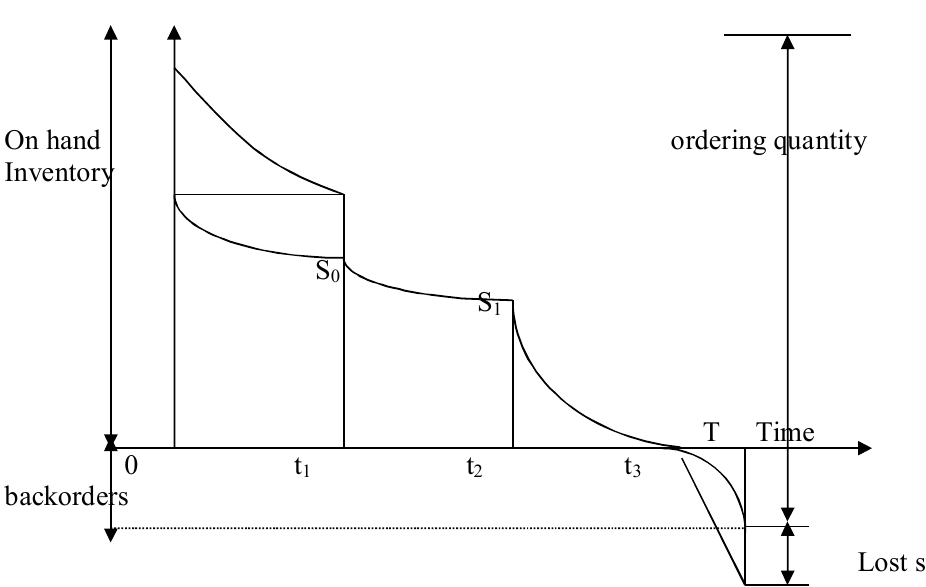
Fig.1. Graphical representation of a two-warehouse inventory